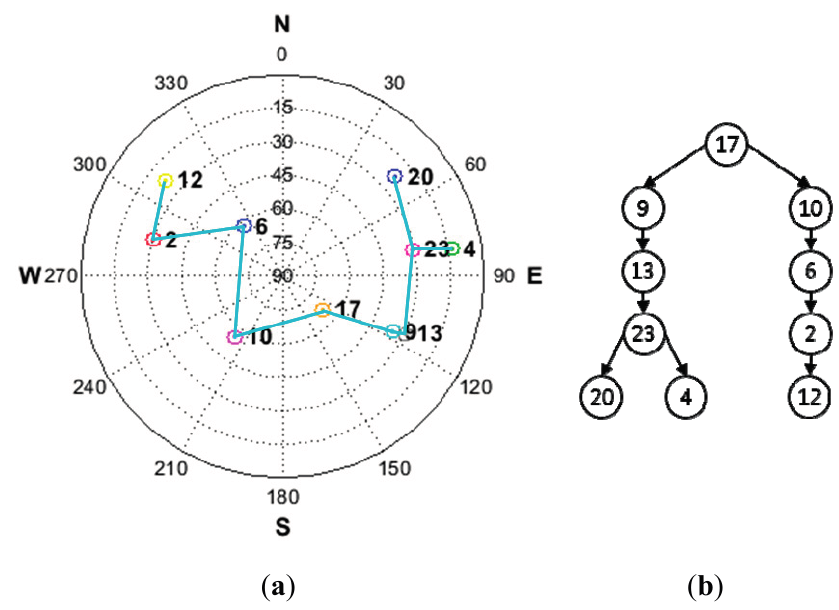
Figure 8. ( a ) Satellite geometry for simulation; ( b ) resulting tree structure for simulation.